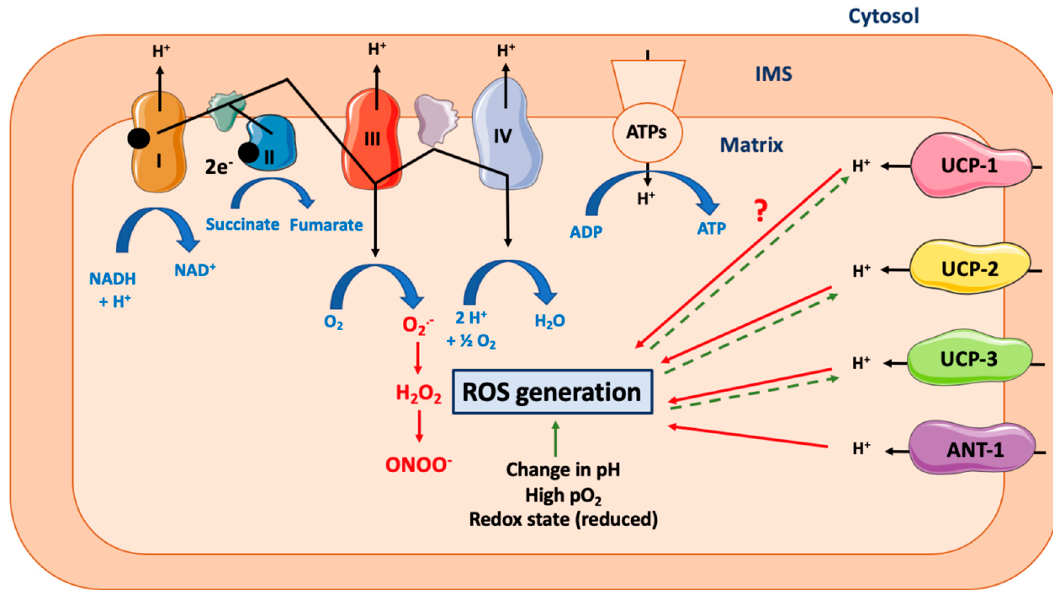
ff ect of mitochondrial uncoupling proteins on mitochondrial ROS generation. Abbreviations: Figure 2. Effect of mitochondrial uncoupling proteins on mitochondrial ROS generation. Figure 2. E ANT-1 (Adenine Nucleotide Transferase-1), ATPs (ATPsynthase), IMS (Inter Membrane Space